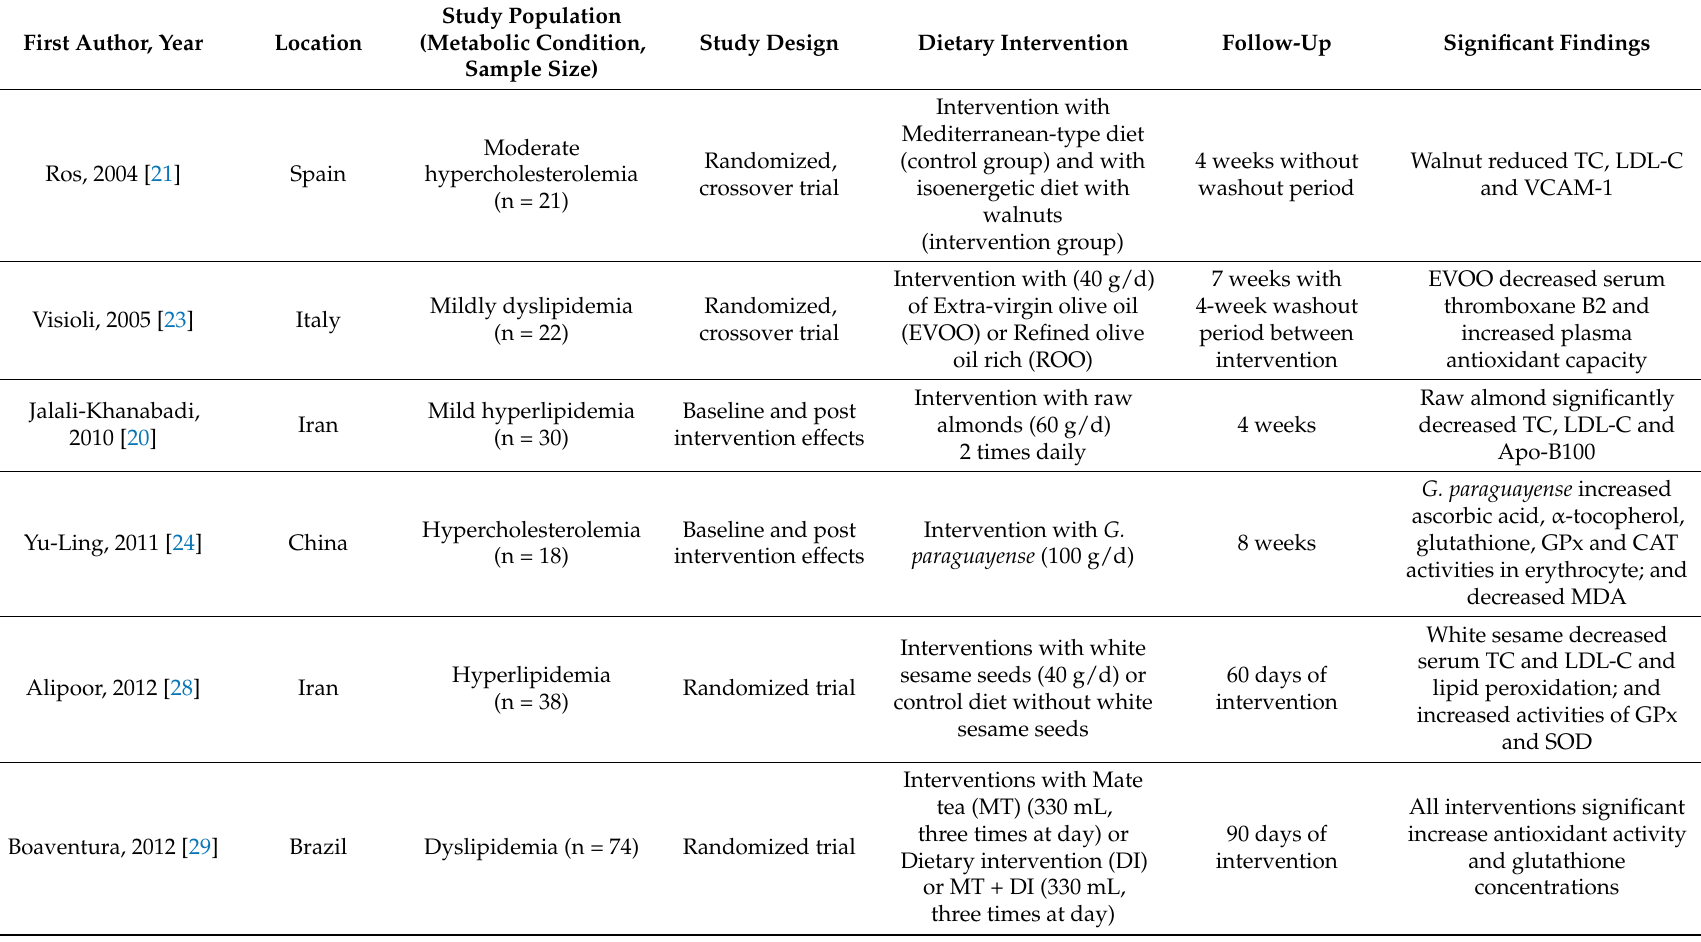
Table 2. Characteristics of the studies including in systematic